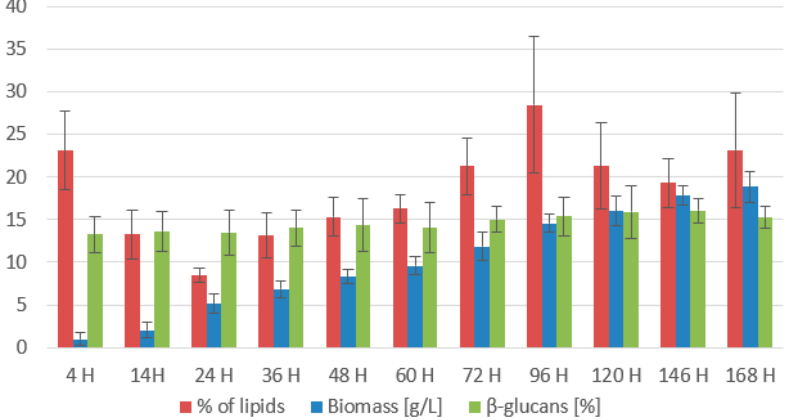
Figure 11. Fatty acid production of Rhodotorula kratochvilovae in a bioreactor cultivation on coffee oil and glycerol with lipase induction.